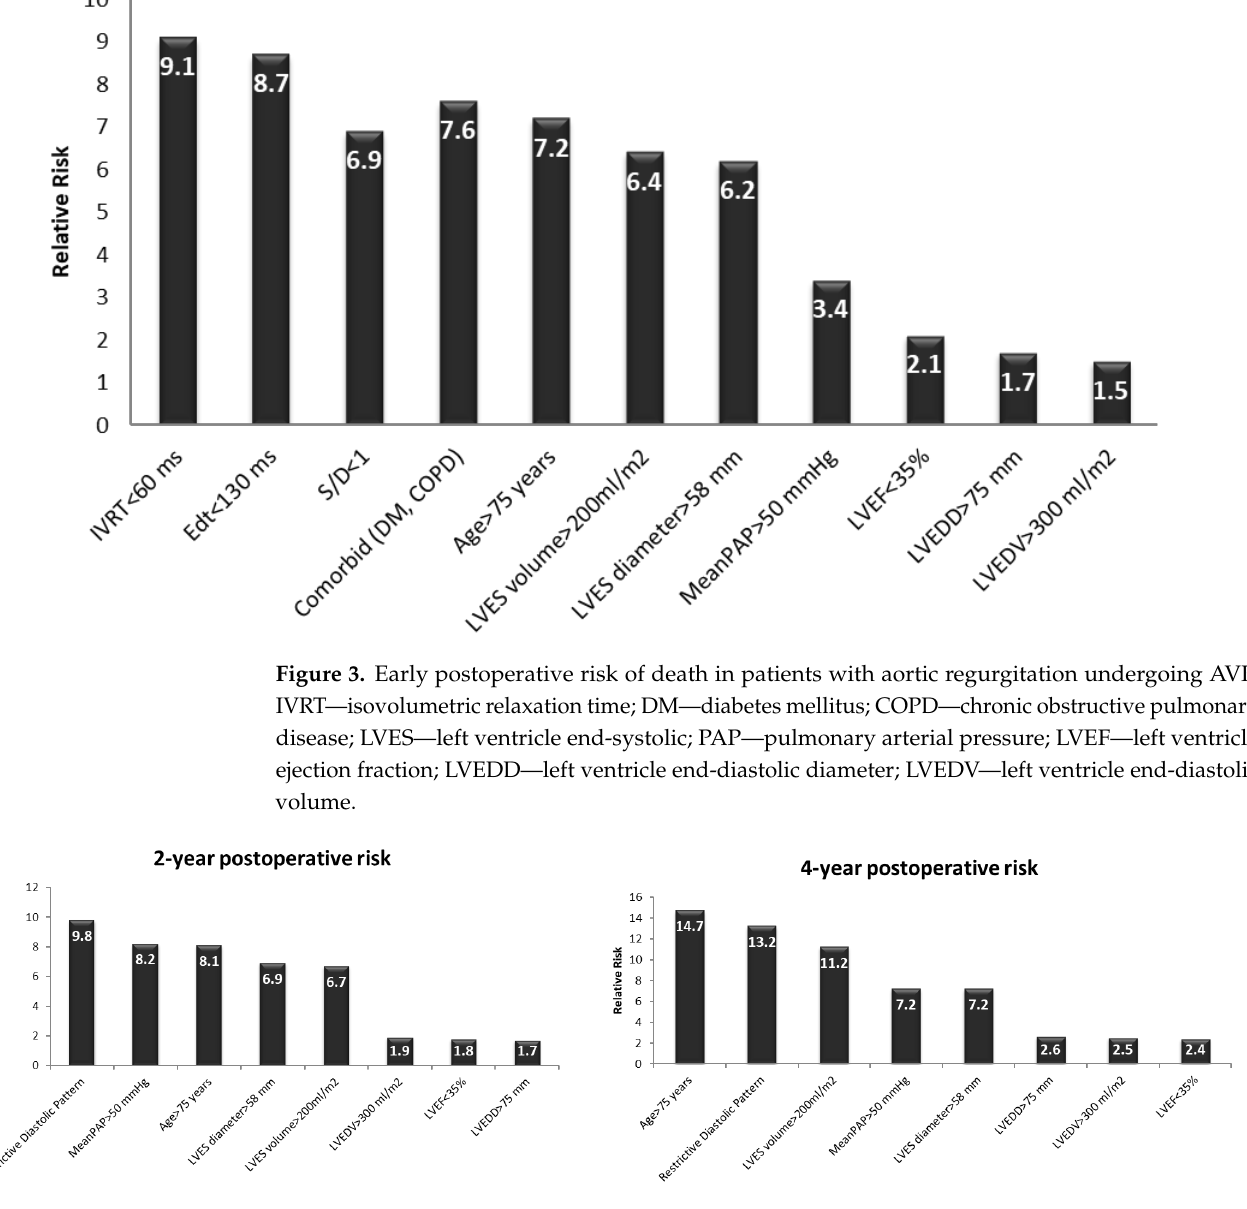
Figure 4. Risk of death at 2 and 4 years postoperatively in patients that received AVR for AR. LVES—left ventricle end-systolic; PAP—pulmonary arterial pressure; LVEF—left ventricle ejection fraction; LVEDD—left ventricle end-diastolic diameter; LVEDV—left ventricle end-diastolic volume.